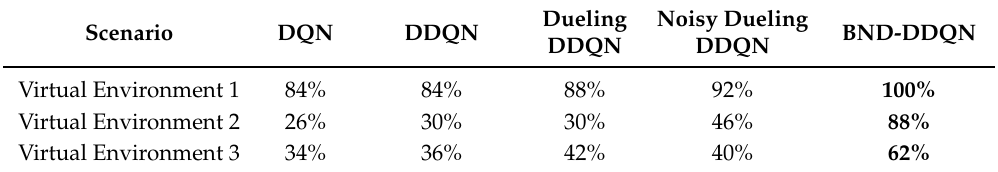
Figure 5. Average total rewards received by various models at different training steps in the second and third virtual environments. The BND-DDQN model results in the highest average rewards compared to baseline methods. Table 1. Comparison between the proposed BND-DDQN model and four baseline algorithms with respect to success rate in various virtual